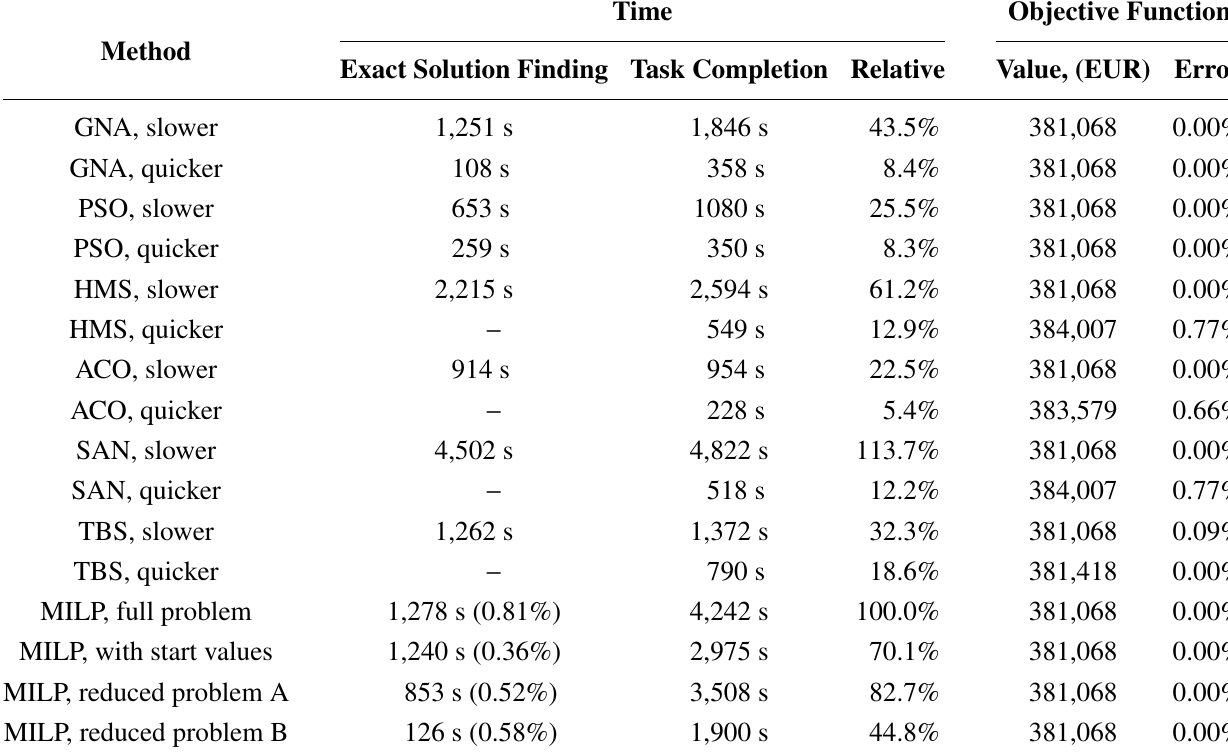
Table 7. Comparison of the applied approaches and